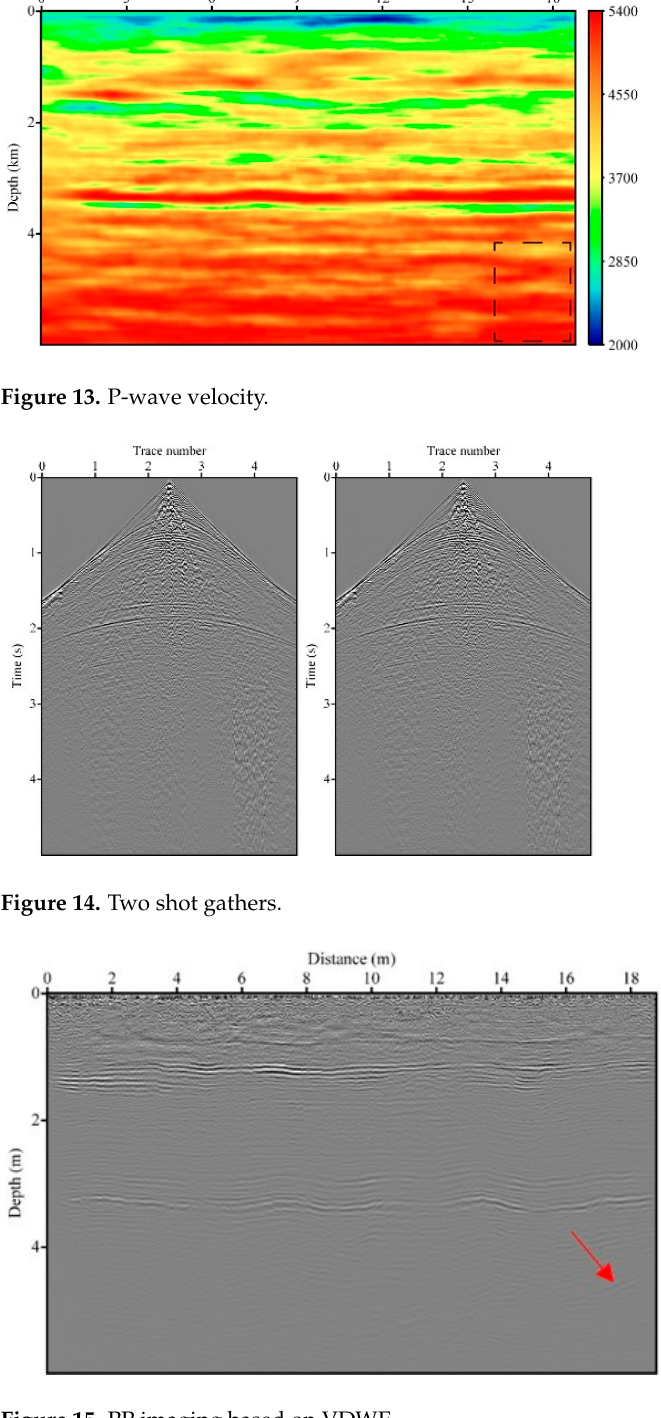
Figure 16. PP imaging based on SVDWE. 4. Discussion Our approach shows the satisfying performance for imaging weakly illuminated structures. When an overall migrated profile is acquired, it is proper to achieve locally